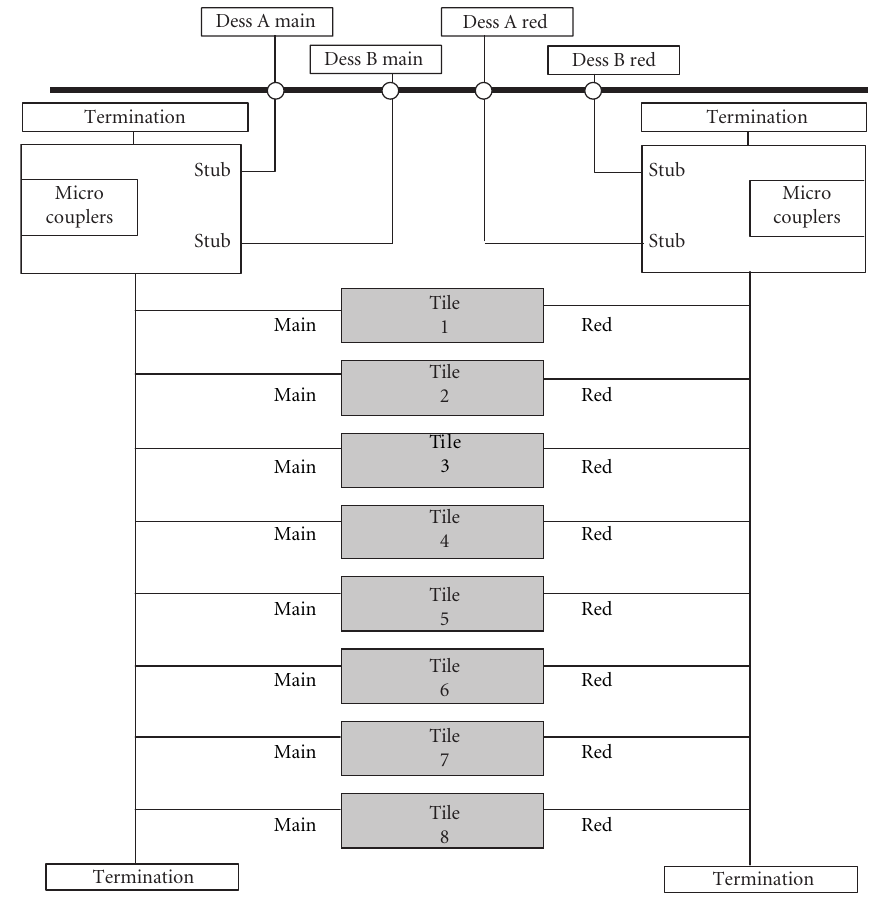
Figure 4: 1553 digital busses for each column of 8 tiles